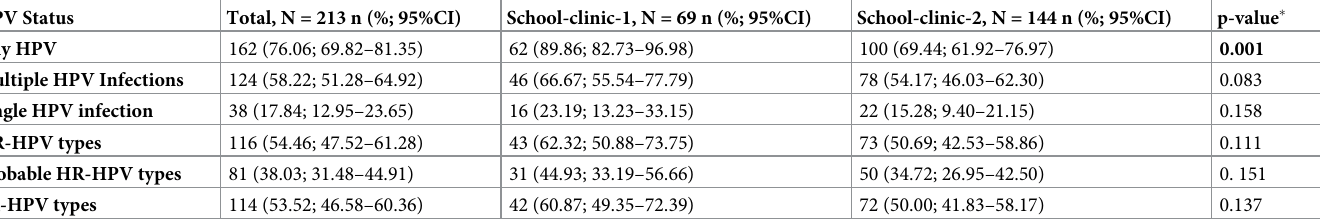
Table 3. Human papillomavirus (HPV) prevalence among sexually active high school female learners, overall and according to study